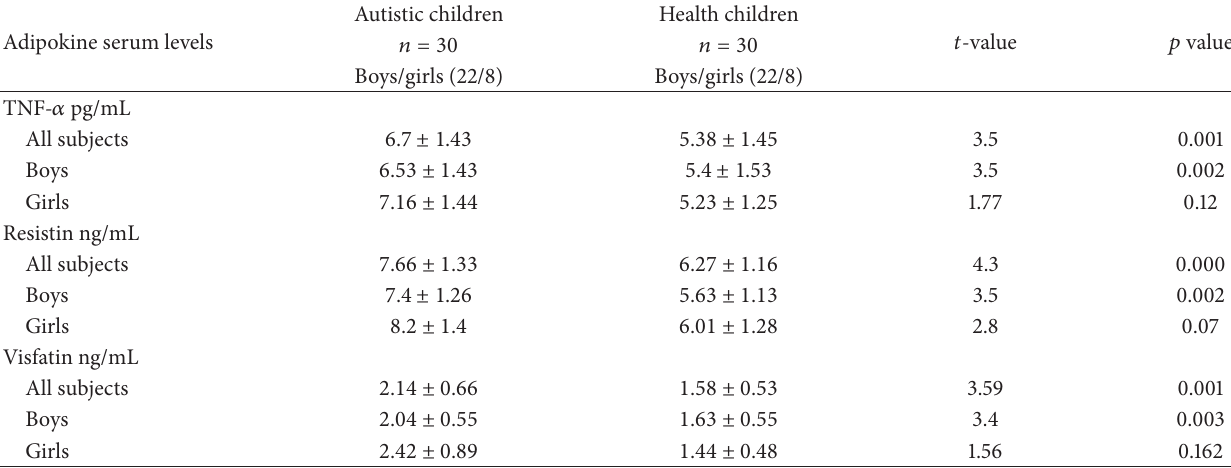
Table 2: Mean values of adipokine serum levels in children autism and healthy